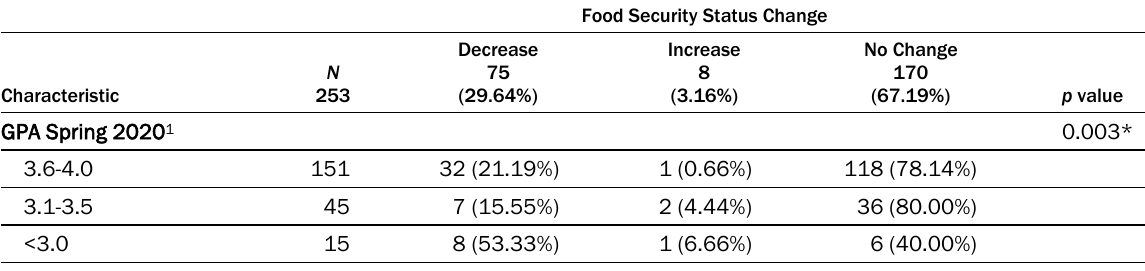
Table 6. Results of Fisher Exact Test for Food Security Status Change and